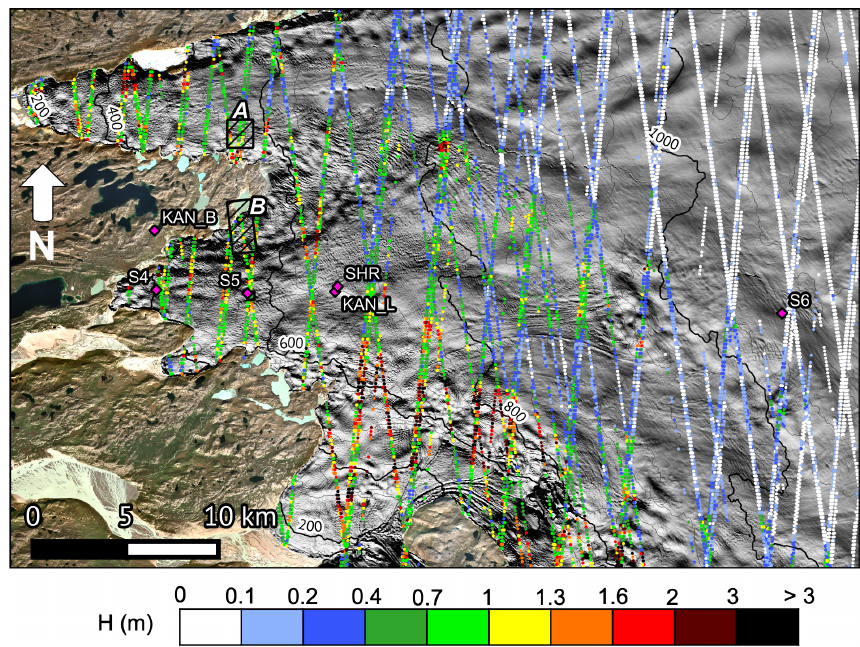
Figure 6. Estimated height of the roughness obstacles ( H ) from ICESat-2 between 16 October 2018 and 6 September 2020 in the lower part of the K-transect, West Greenland. The locations of the automatic weather stations are given by the pink diamonds. The black boxes A and B delineate the areas mapped by UAV photogrammetry. A hillshade of ArcticDEM (Porter et al., 2018) is shown as background over the ice